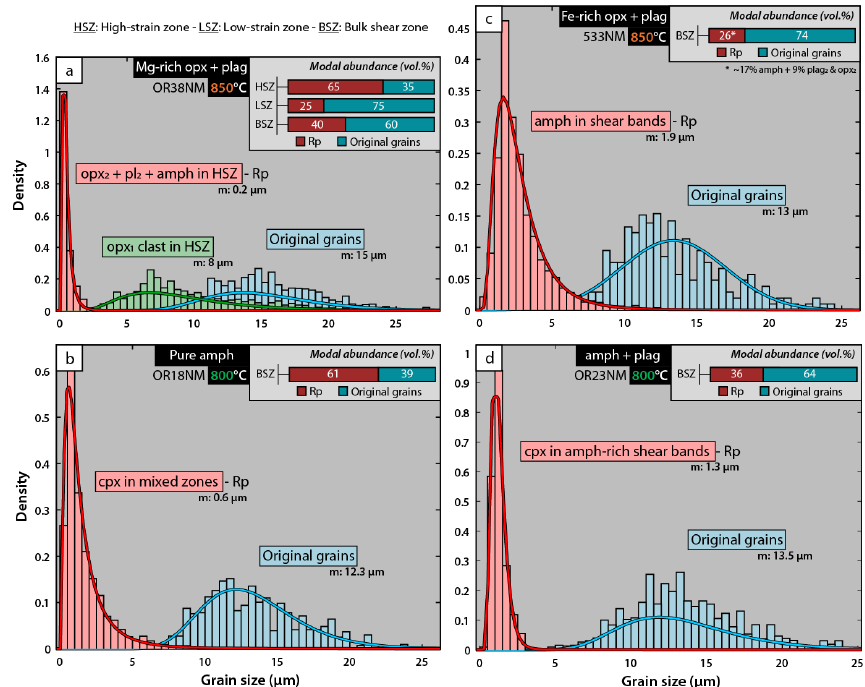
Figure 11. Grain size distribution reported as a histogram of grain size versus density for different category of grains in the Mg-rich opx + plag (a) , pure amph (b) , Fe-rich opx + plag (c) , and amph + plag (d) assemblages. Overall, there is a significant and systematic reduction in grain size between the original grains and the reaction products. The lognormal distribution curves are fit for each grain size distribution. The modal proportion (vol.%) of reaction products and original grains of each assemblage is also